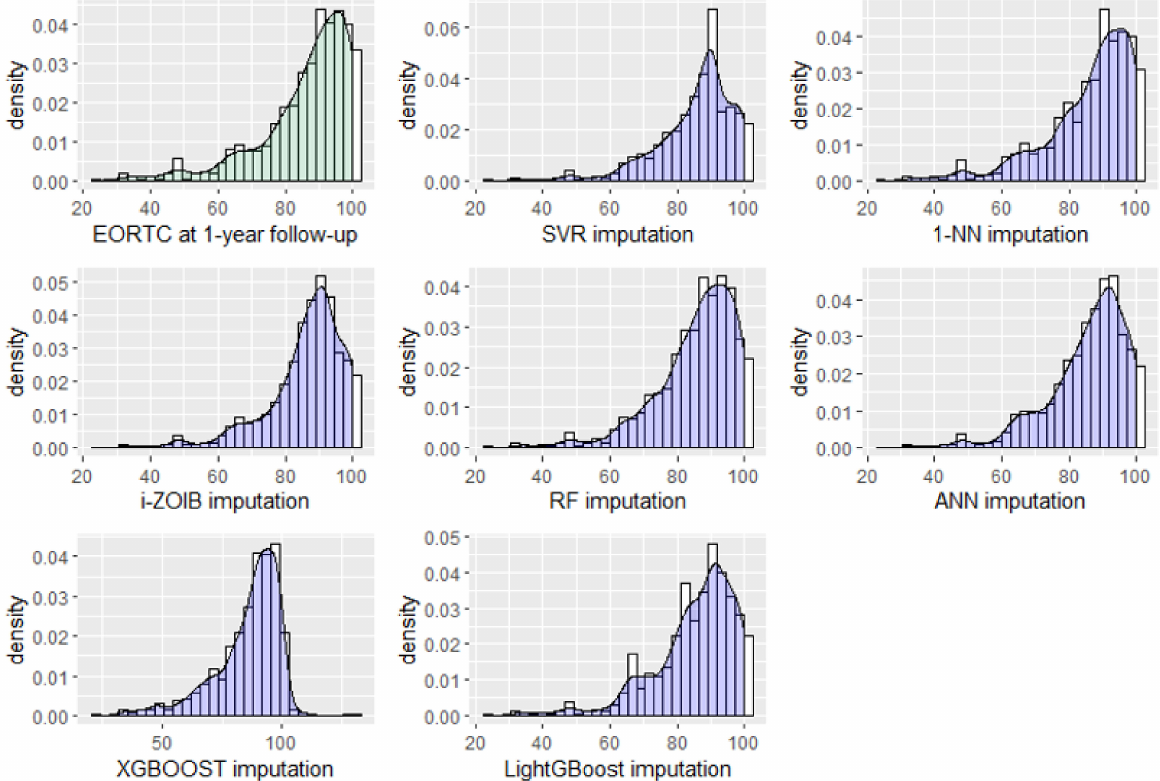
Figure 10. Distribution of the observed EORTC QLQ-C30 scores at follow-up ( green ) and after applying the imputation methods ( purple